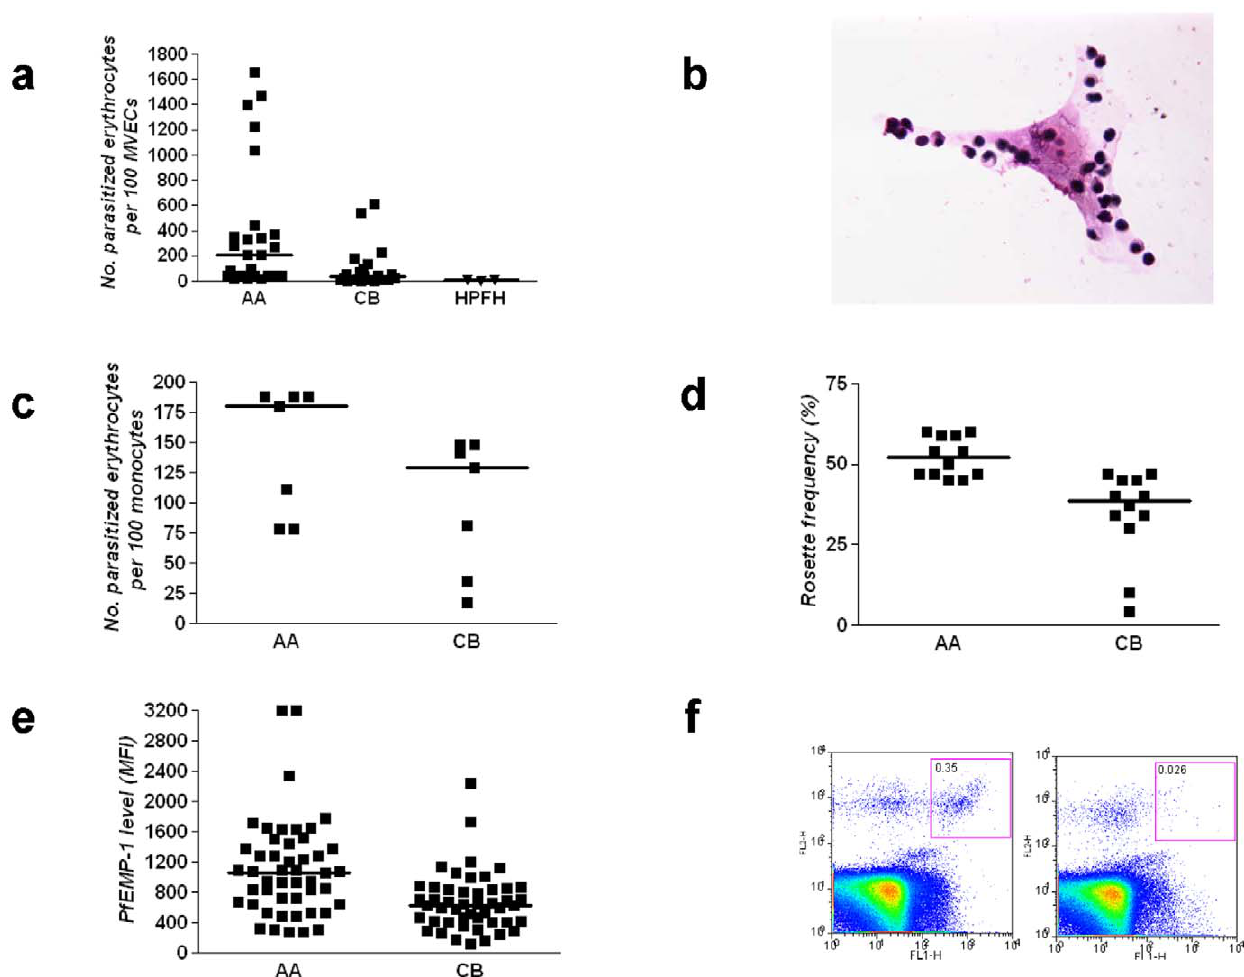
Figure 2. Cytoadherence and surface PfEMP-1 levels of parasitized RBCs containing HbF. a , Adherence of parasitized RBCs to MVECs. The numbers of parasitized AA, CB, and HPFH RBCs adhering to 100 MVECs are shown. Median values are indicated by horizontal bars. Results were obtained from 4 parasite lines (3D7, 7G8, A4tres, FCR-3), multiple blood donors (7AA, 10CB, 1HPFH), and 5 endothelial cell lots (not all combinations tested). b , The photomicrograph shows the adherence of parasitized AA RBCs to MVECs. c , Adherence of parasitized RBCs to blood monocytes. The numbers of parasitized AA and CB RBCs adhering to 100 monocytes are shown. Median values are indicated by horizontal bars. Results were obtained from 3 parasite lines (3D7, A4tres, FCR-3), multiple blood donors (4AA, 7CB), and 4 monocyte donors (not all combinations tested). d , Rosette frequencies of parasitized RBCs. Median values are indicated by horizontal bars. Results were obtained from 2 parasite lines (MC/R + , TM284) and multiple blood donors (4AA, 7CB) (not all combinations tested). e , PfEMP-1 expression levels (median fluorescence intensities, MFI) on the surface of parasitized RBCs. Mean values are indicated by horizontal bars. Results were obtained from 2 parasite lines (MC/R + , FVO), multiple blood donors (4AA, 7CB), and various concentrations of 2 antisera. f , Flow cytometry analysis of PfEMP-1 expression on AA (left panel) and HPFH (right panel) RBCs infected with the FVO P. falciparum line. Parasitized RBCs reactive to PfEMP-1-specific antiserum appear as a clustered population in the upper right quadrant (left panel).